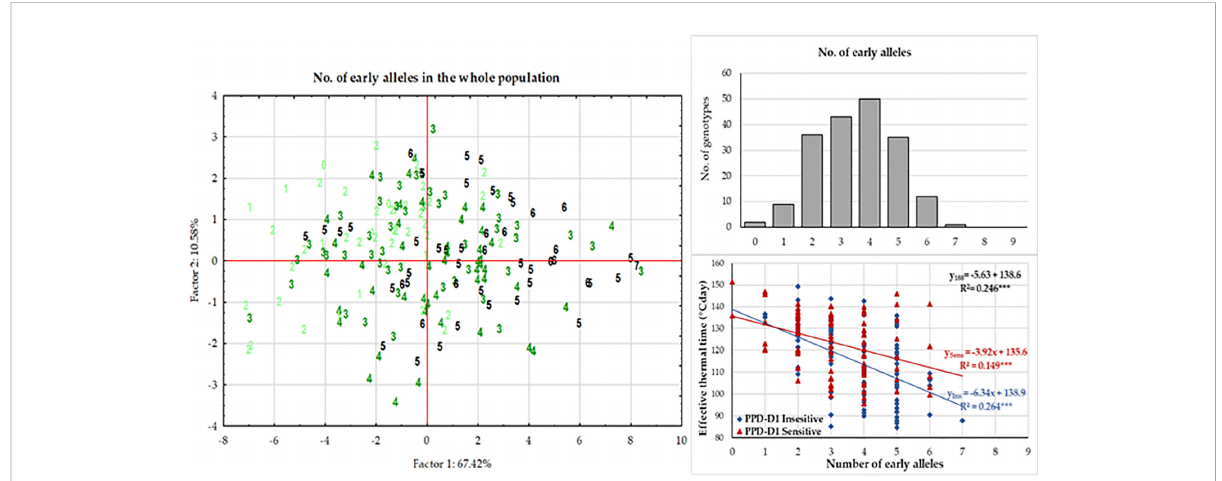
FIGURE 6 Effects of the number of early alleles in the signi fi cant markers on plant development of 188 winter wheat genotypes as represented by the Principal Component analysis on the data matrix of fi ve developmental phases in three seasons and by the association between effective thermal time to fi rst node appearance